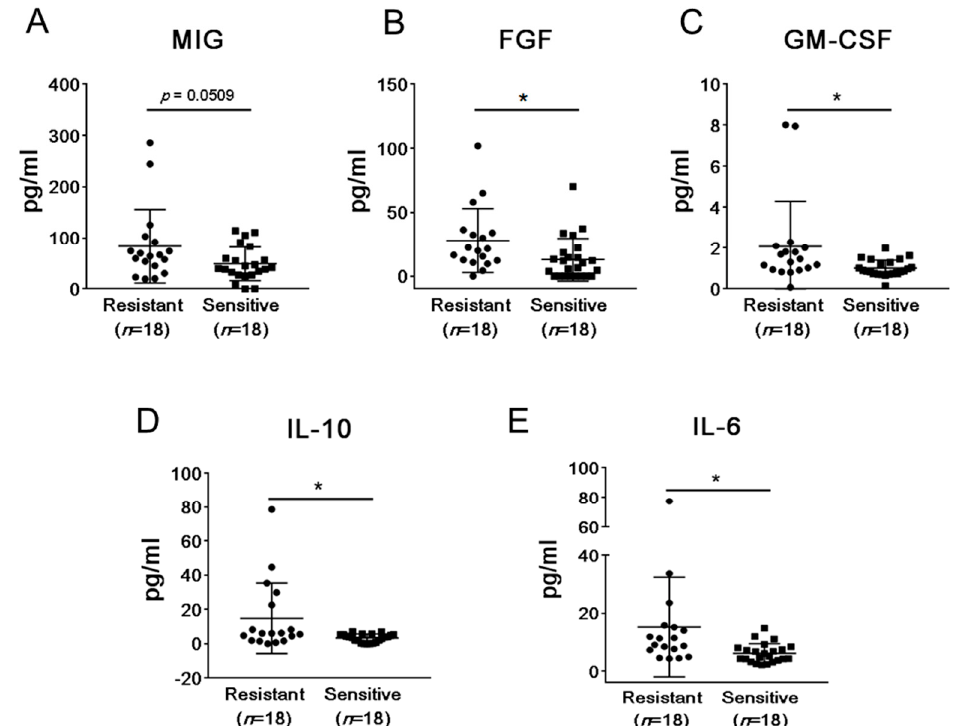
Figure 1. The comparison of plasma levels of immune-related protein mediators between patients sensitive and resistant to abiraterone and / or enzalutamide treatment. Baseline levels of 30 soluble immune mediators were analyzed in plasma samples derived from 23 patients responding to therapy (sensitive) and 18 patients resistant to therapy with progressing disease using Luminex analysis. Shown are results for the significantly altered analytes: monokine induced by gamma interferon (MIG) ( A ), fibroblast growth factor (FGF) ( B ), granulocyte-macrophage colony-stimulating factor (GM-CSF) ( C ), interleukin 10 (IL-10) ( D ), and IL-6 ( E ). * p < 0.05.